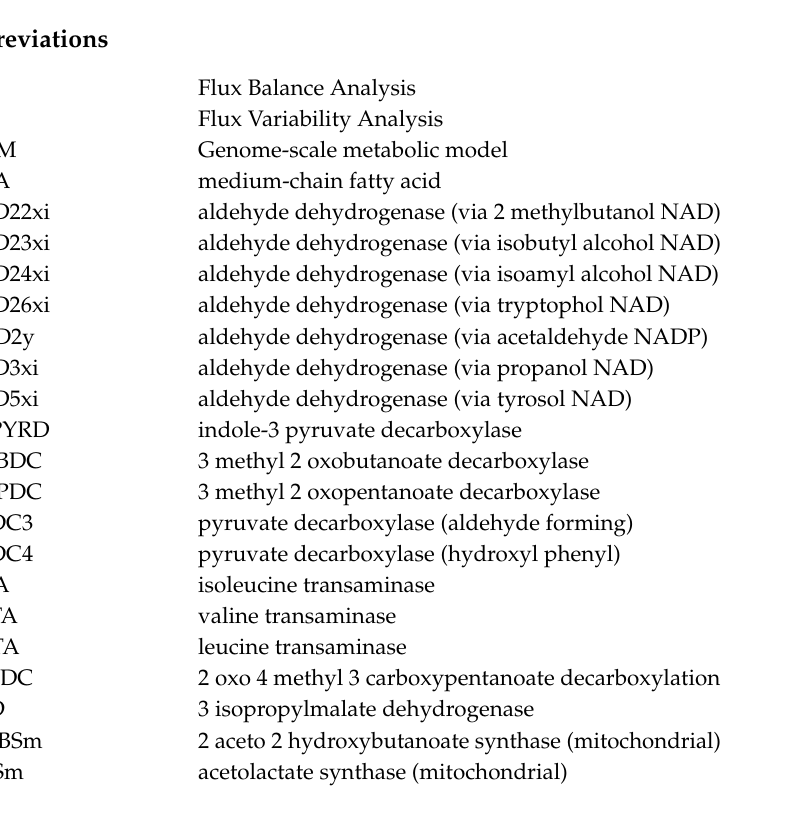
Figure S1. Comparison of GSMM simulations (Red bars) with experimental data [30] (Blue bars). Model predicted and experimental values for biomass growth rates, primary metabolite production fluxes, and secondary metabolite production fluxes represent conditions for Case III and Case IV. Experimental data are shown with standard deviation error bars; Figure S2. Comprehensive metabolic network map of yeast ( S. cerevisiae ); Figure S3. Network map of central carbon metabolism (left) and amino acid metabolism (right). Network fluxes were determined using data from Case I where the network illustrates the optimal solution from FBA. The fluxes were scaled between − 1 and + 1 for ease of visualization; Figure S4. Network map of central carbon metabolism (left) and amino acid metabolism (right). Network fluxes were determined using data from Case II where the network illustrates the optimal solution from FBA. The fluxes were scaled between − 1 and + 1 for ease of visualization; Table S1. Genes added to current GSMM; Table S2. Metabolites added to current GSMM; Table S3. Reactions added to current GSMM; Table S4. Experimentally measured consumption / production rates of the di ff erent metabolites analyzed from Quiros et al. 2013 and constraints used in the